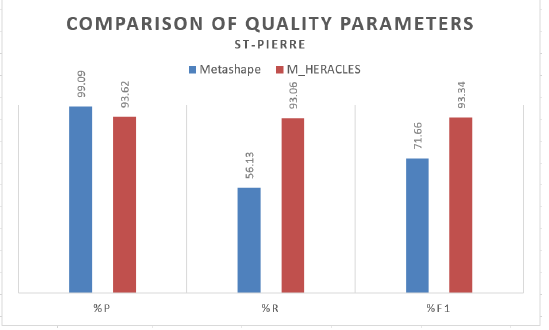
Figure 8. Histogram representation of the quality parameters for the St-Pierre dataset comparing Metashape against M_HERACLES.